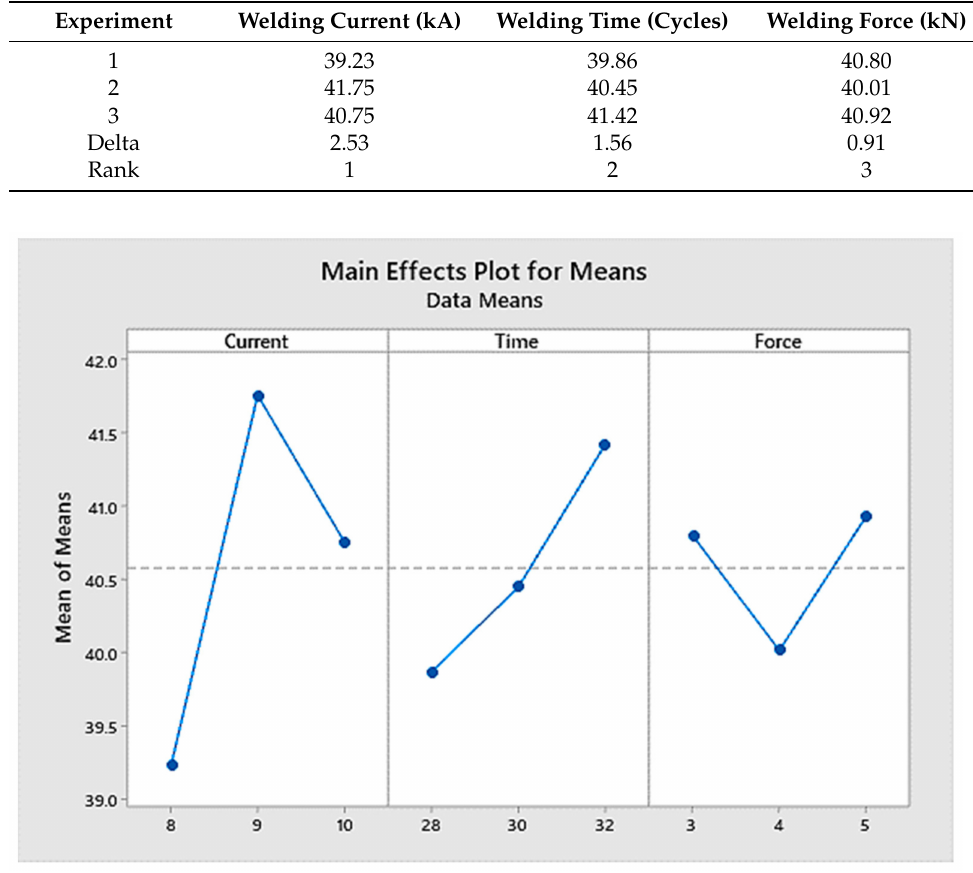
Figure 5. The significant effect plot of RSW parameters on the weld nugget